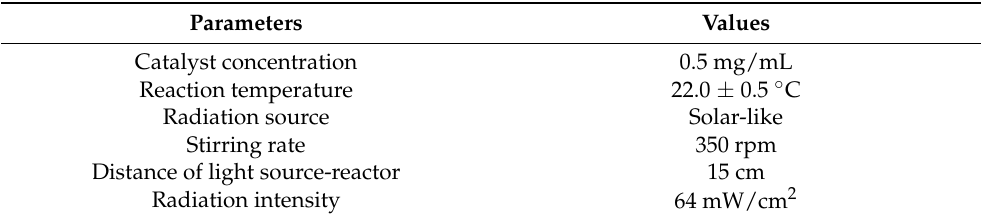
Table 5. Set up of measurement parameters of the photocatalytic